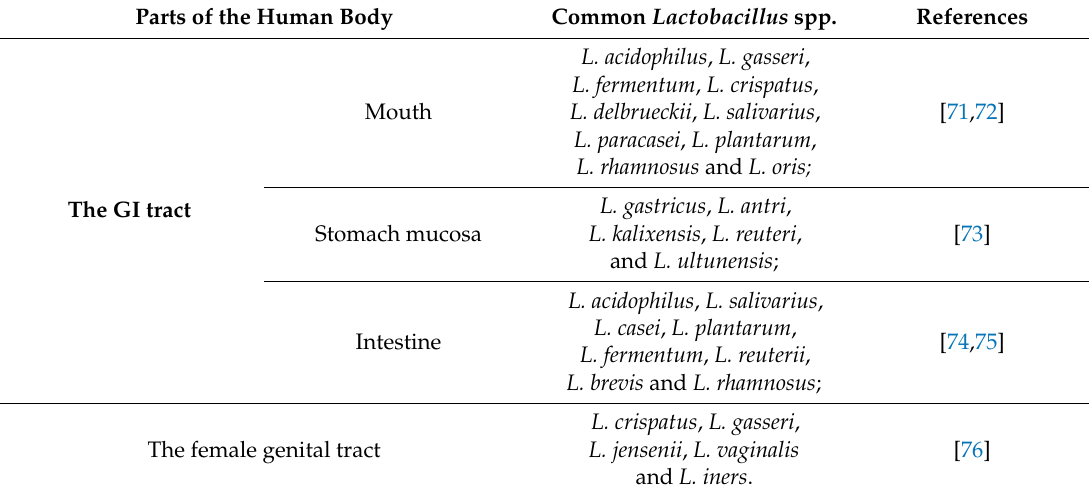
Table 1. Common Lactobacillus spp. colonizing the human